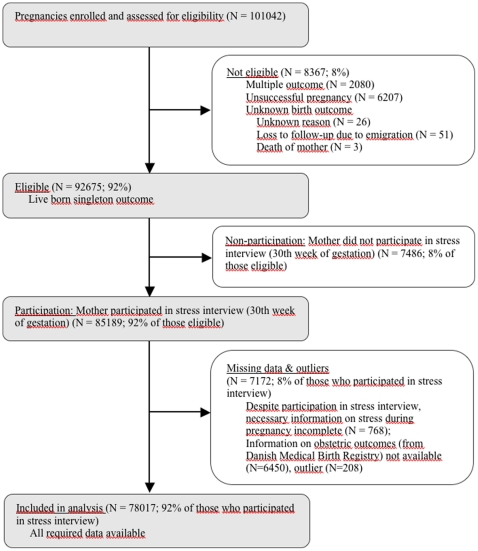
Flowchart of Study Participants.